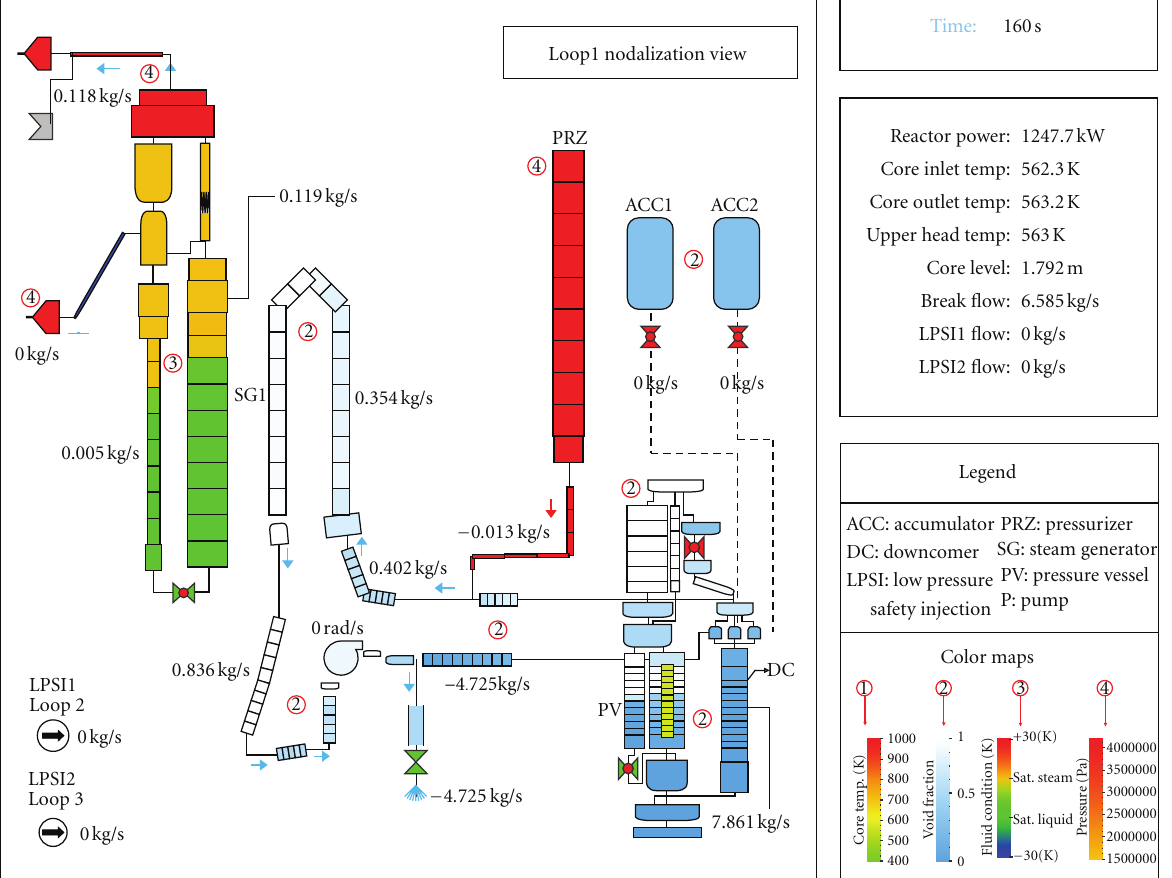
Figure 19: Animation mask for RELAP5 at time t = 160 s (after loop seal